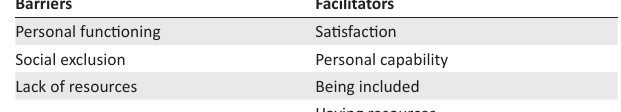
TABLE 2: Categories for barriers and facilitators. Barriers